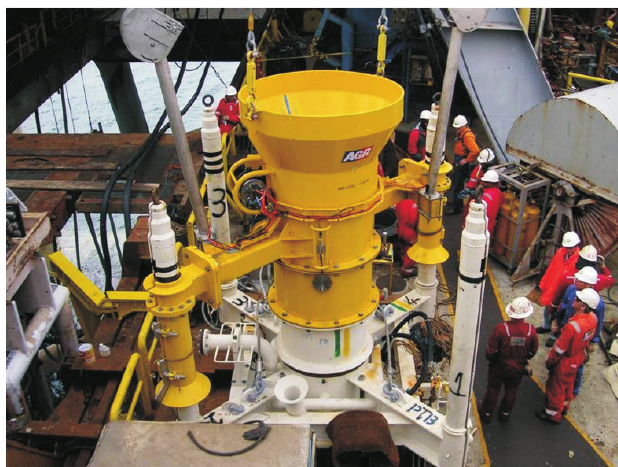
Figure 4. The AGR riserless mud recovery subsea equipment consists of a mud suction module (see above) and seafloor mud pumps. The mud is collected in the mud suction module and returned to the drillship via the seafloor mud pumps (image: courtesy of John